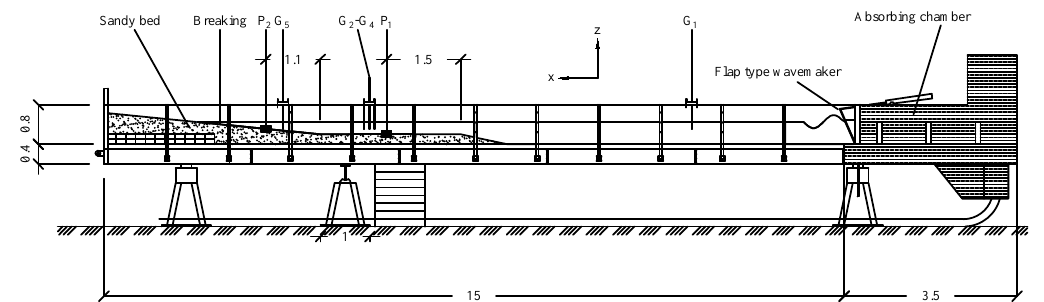
Figure 1. Experimental set up adopted in the present experimental campaign. P 1 and P 2 indicate the location of the two ripples subject to hydrodynamic measurements, respectively on the flat and the sloping bed; G 1 – G 5 indicate the wave gauge positions along the flume. The x -axis of the reference system points in the wave propagation direction while the z -axis points